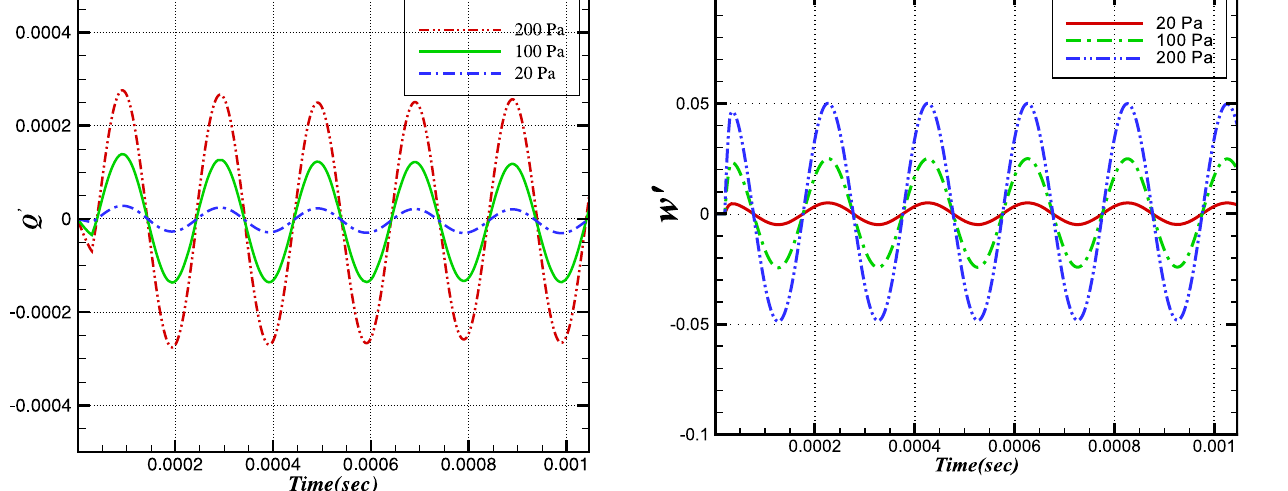
Figure 10. Relative change in the heat release at different amplitudes and a constant frequency of 5 kHz.